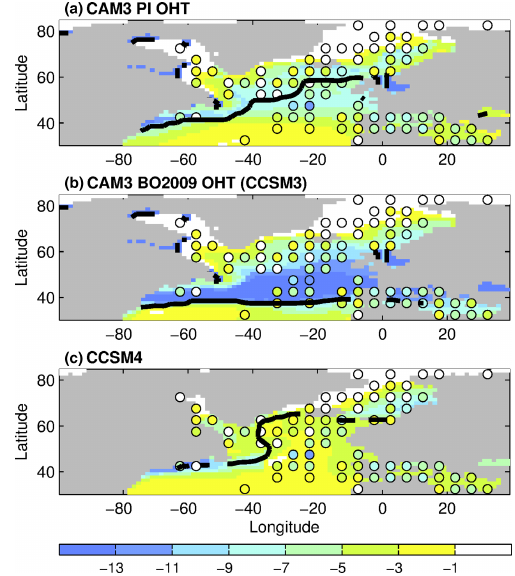
Figure 3. The colored shading illustrates the simulated annual mean SST anomalies (LGM-PI; in ◦ C) in the North Atlantic from the CAM3 simulations using (a) PI OHT and (b) BO2009 OHT (Brandefelt and Otto-Bliesner, 2009) as well as (c) the LGM simula- tion from Brady et al. (2013) using the Community Climate System Model version 4 (CCSM4). The equatorward location of the annual mean sea-ice margin in the respective LGM simulation is depicted by the thick black contours in each panel. The colored markers in each panel show the (annual mean) LGM SST anomaly (LGM-PI) from the MARGO (Multiproxy Approach for the Reconstruction of the Glacial Ocean surface) SST reconstruction (MARGO Project Members et al.,